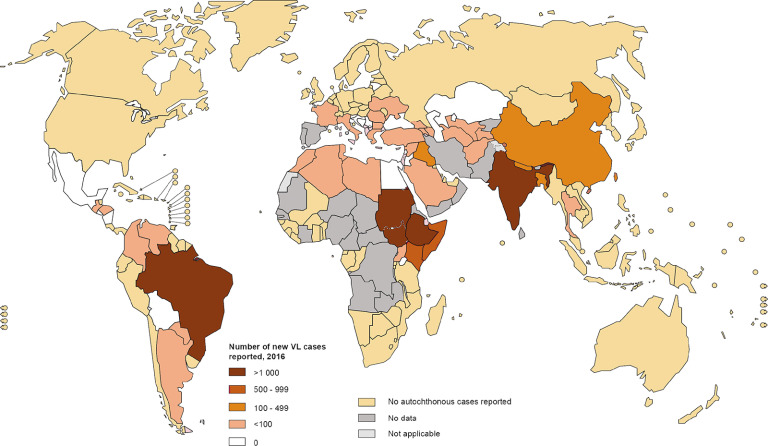
Status of Endemicity of Visceral Leishmaniasis Worldwide38